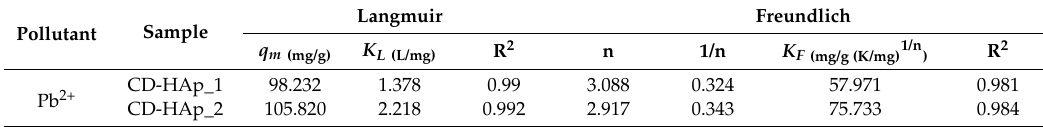
Table 2. Isotherms parameters for lead adsorption onto CD-HAp_1 and CD-HAp_2.